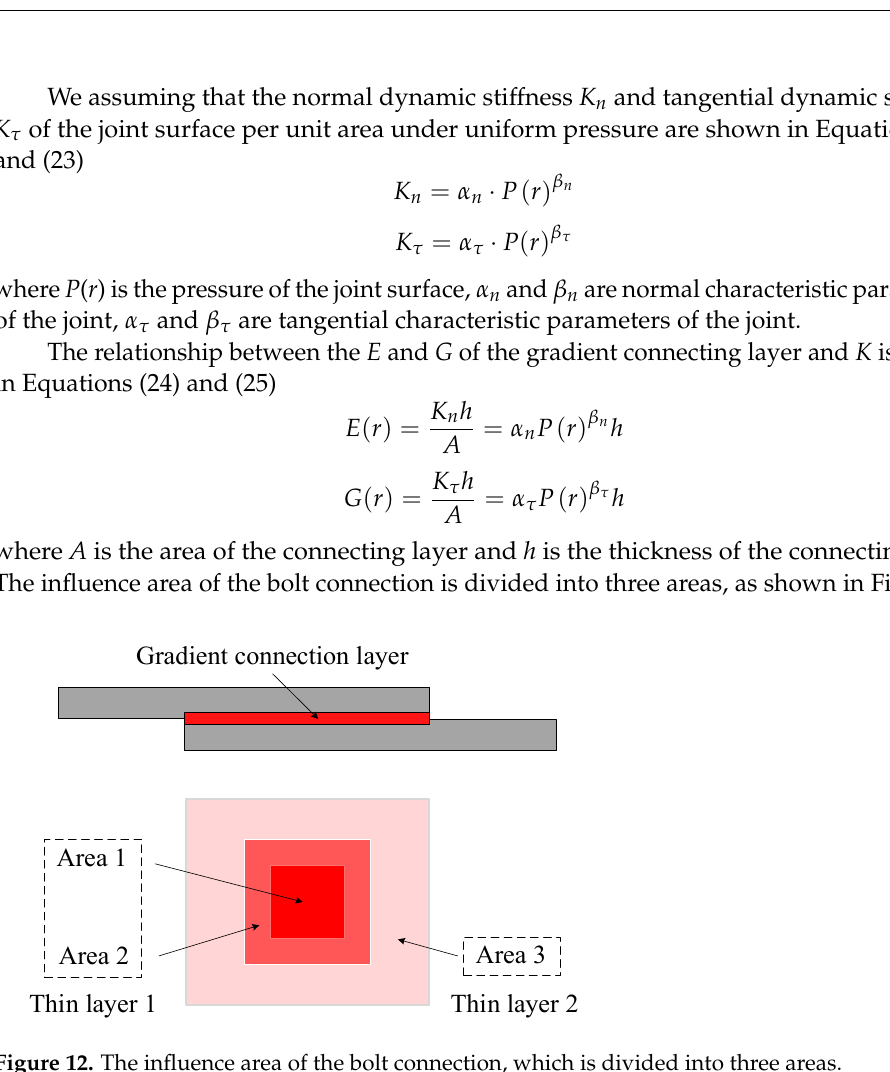
Figure 13. FEM of the connection